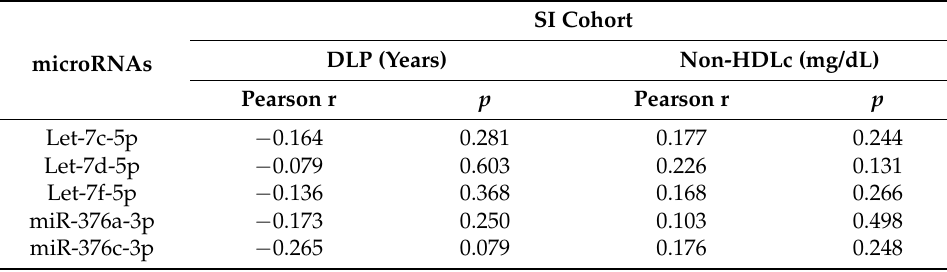
Figure 2. Boxplots of miRNA expression levels in NSI and SI cohorts. The analysis was carried out using qPCR. Data are presented in log2. Data represent the mean ± SEM. * p < 0.05, ** p < 0.01, *** p < 0.005. Error bars represent SDs. NSI, non-statin intolerant; SI: statin intolerant. Table 2. Correlation between the clinical parameter (DLP and non-HDLc) and individual mi- croRNAs in SI subjects. DLP: years of dyslipidemia; non-HDLc: non-high-density lipoprotein cho- lesterol SI: statin intolerant. Coefficient significant at p < 0.05.